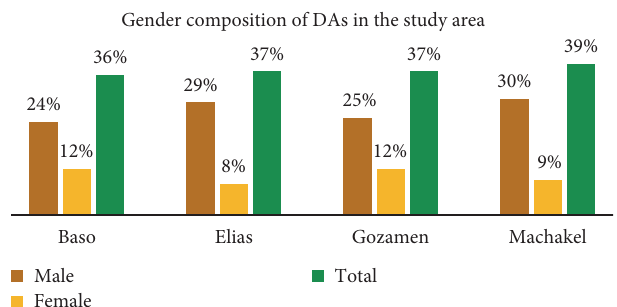
F IGURE 4: Gender composition of respondent DAs among the four